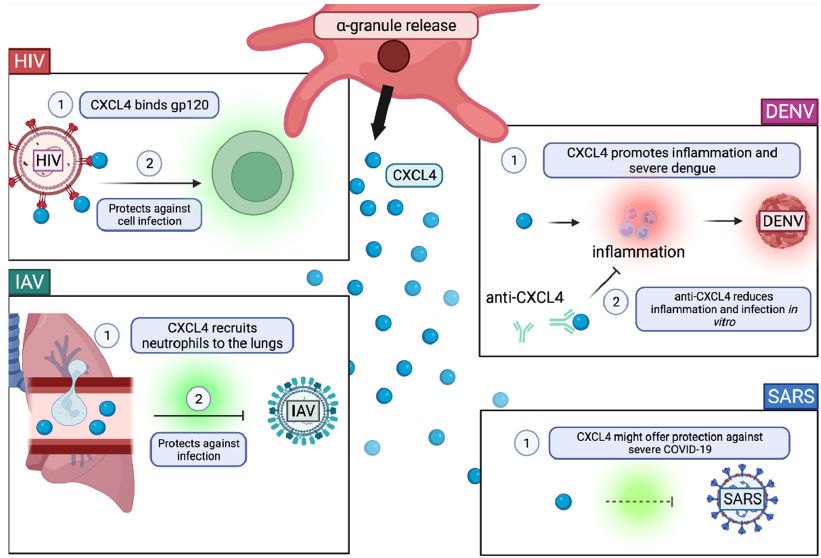
Figure 4. Role of α -Granules in Viral Infection. α -granule released from activated platelets contain CXCL4, a cytokine. In human immunodeficiency virus (HIV) infection, CXCL4 binds the major HIV surface protein gp120, which protects against cell infection. In dengue virus (DENV) infection, CXCL4 is known to promote inflammation and severe dengue. Anti-CXCL4 reduces inflammation and DENV infection in vitro. In influenza A virus (IAV) infection, CXCL4 recruits neutrophils to the lungs, which helps fight against infection. In SARS-CoV-2 infection, decreased plasma CXCL4 is correlated with poor disease progression, indicating that CXCL4 plays a protective role. Created with BioRender.com (9 February